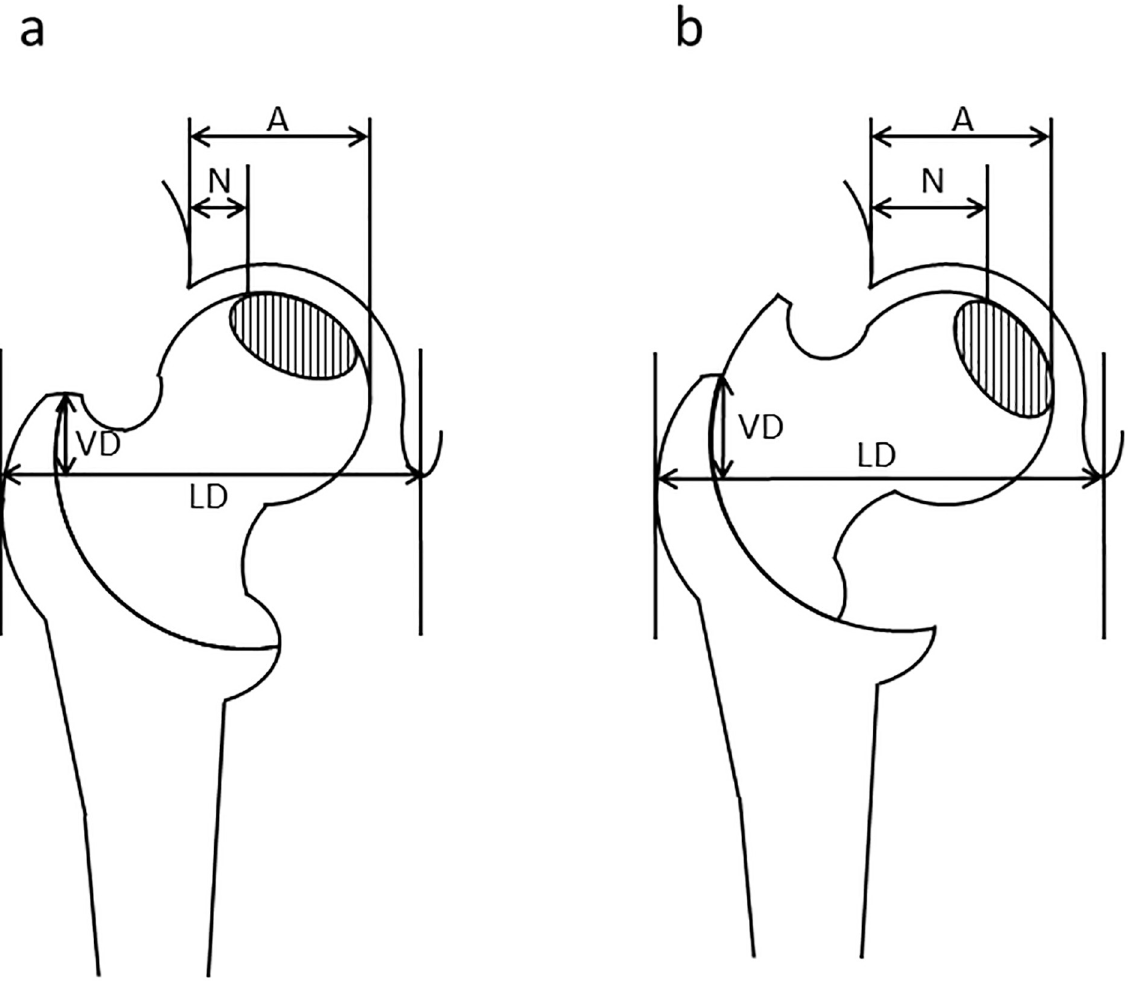
Fig 3. Diagram for the measurement of leg shortening and lateralization and the lateral head index (LHI). a) Before and b) after osteotomy. Shaded area represents the necrotic region. LHI was calculated as the width of the intact region (N) divided by the full length of the femoral head (A) and expressed as a